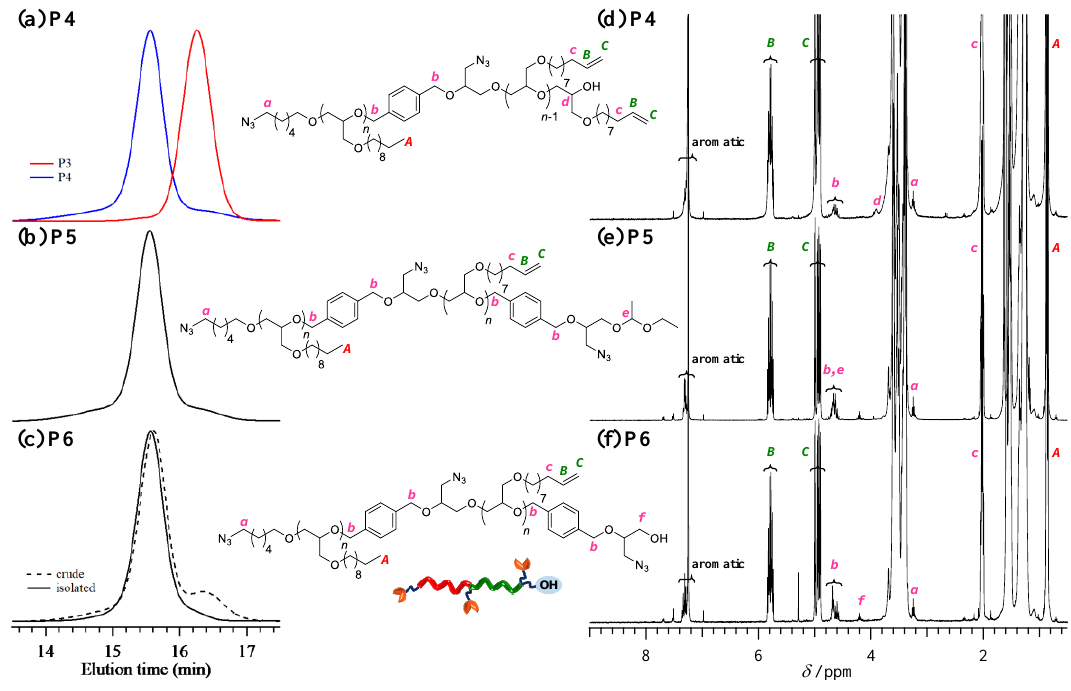
Figure 2. ( a – c ) SEC traces of P4 (red line, first polymerization of M1 ; blue line, after the block copolymerization of M2 ), P5 , and P6 (dotted line, before purification; solid line, after purification